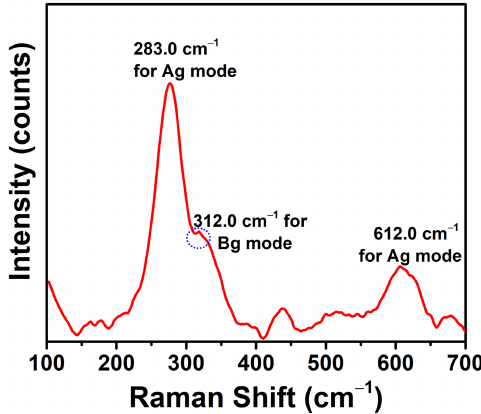
Figure 3. Raman spectra of bio-reduced CuO NPs.